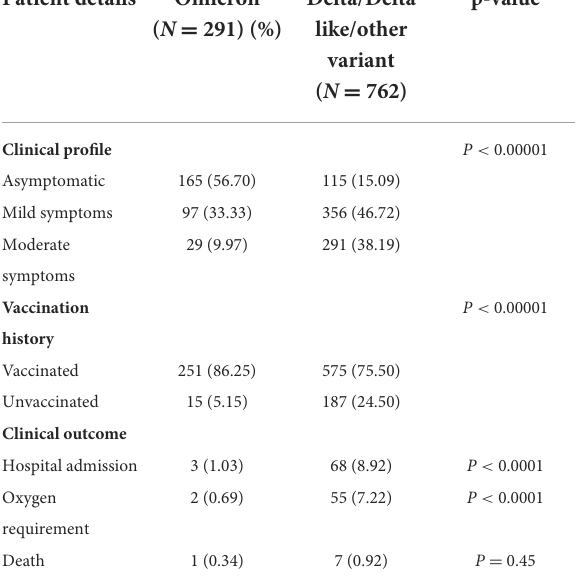
TABLE 2 Clinical outcome in Omicron and Delta